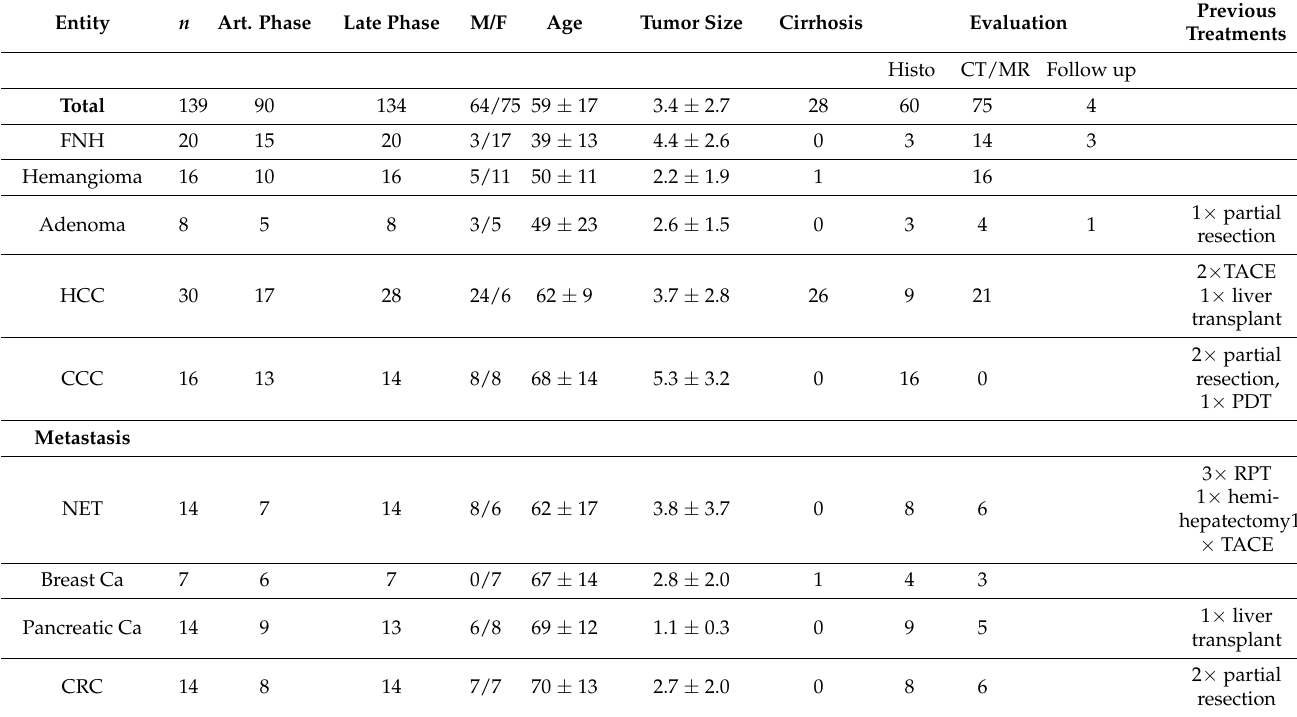
Table 1. Study cohort ( n = 139) with subgroups of different focal liver